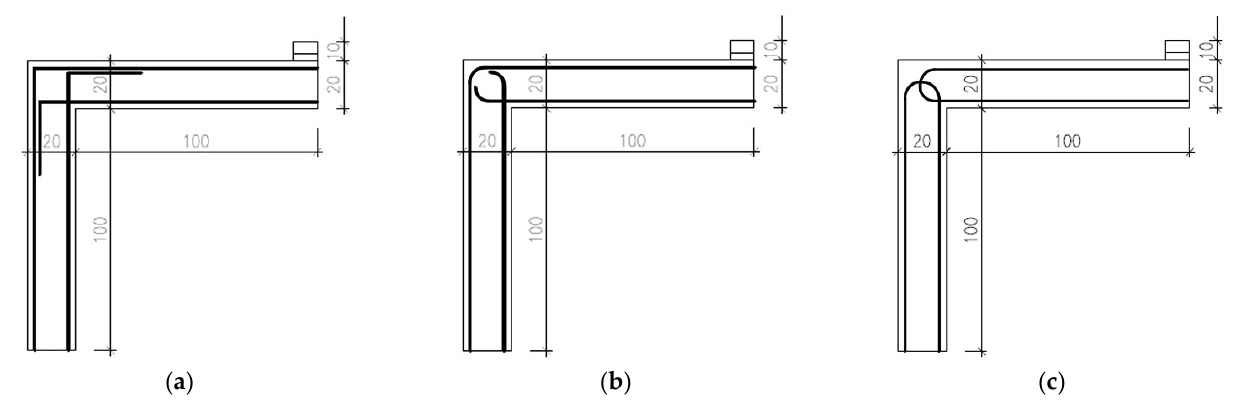
Figure 5. Three examples of reinforcement shape design. Schemes with dimensions for creating a numerical model in the Atena Engineering software. Sharply bent reinforcement ( a ); bent reinforce ‐ ment ( b ); closed reinforcement ( c ).